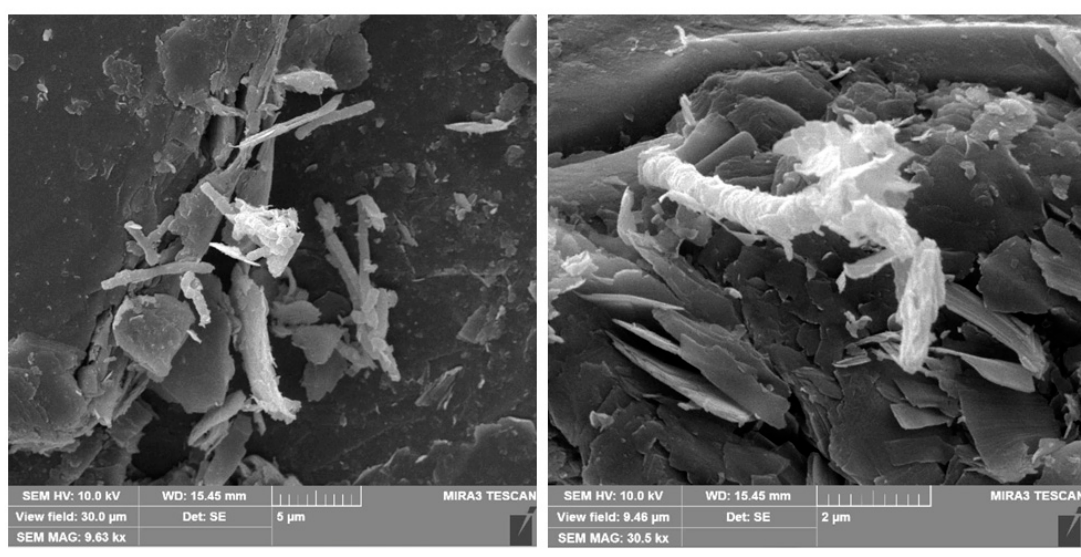
Figure 6. SEM images of critical point dried samples illustrating the sorptive immobilization of the phenol-degrading bacterium Rhodococcus aetherivorans UCM Ac-602 on vermiculite: the rod-shaped bacterial cells were not only attached to the surfaces of large vermiculite particles but also appeared to be enveloped by the small mineral particles. These are representative images from the study by Nogina et al. (2020) [308].